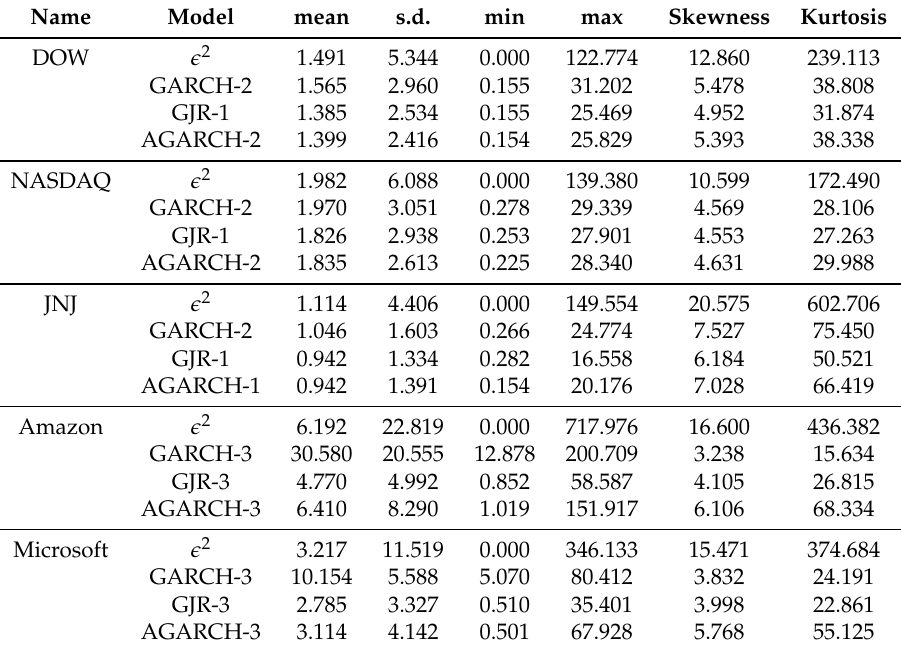
Table 9. Summary Statistics of the Conditional Variance